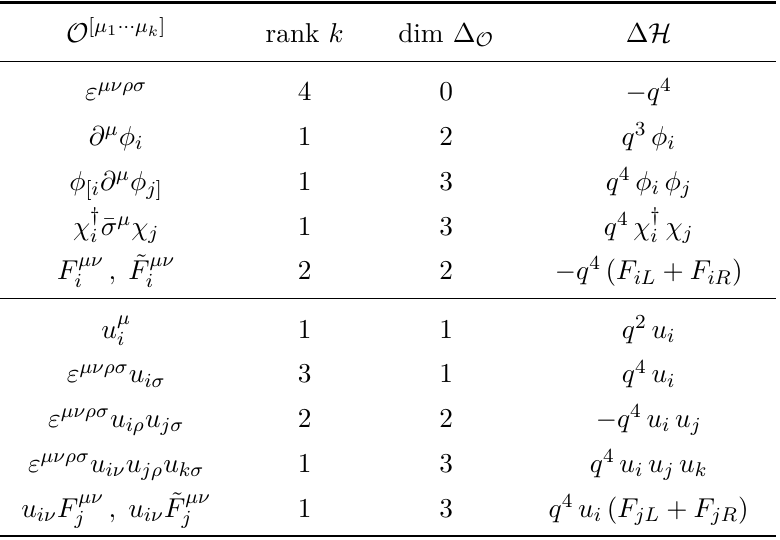
Table 1 . Generic co-closed but not co-exact form operators O [ µ 1 ··· µ k ] that could be built out of scalars φ , left-handed Weyl fermions χ i We give the corresponding contributions to ∆ H in the case of considering no internal